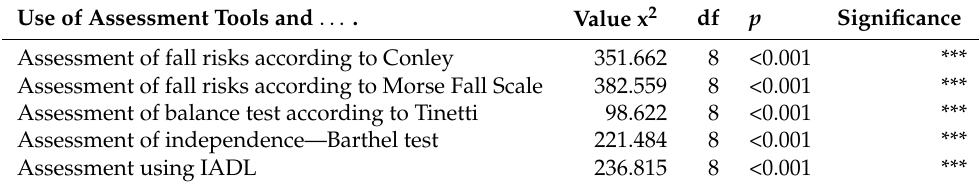
Table 6. Correlations between the use of tools and their introduction into practice. Use of Assessment Tools and . . .